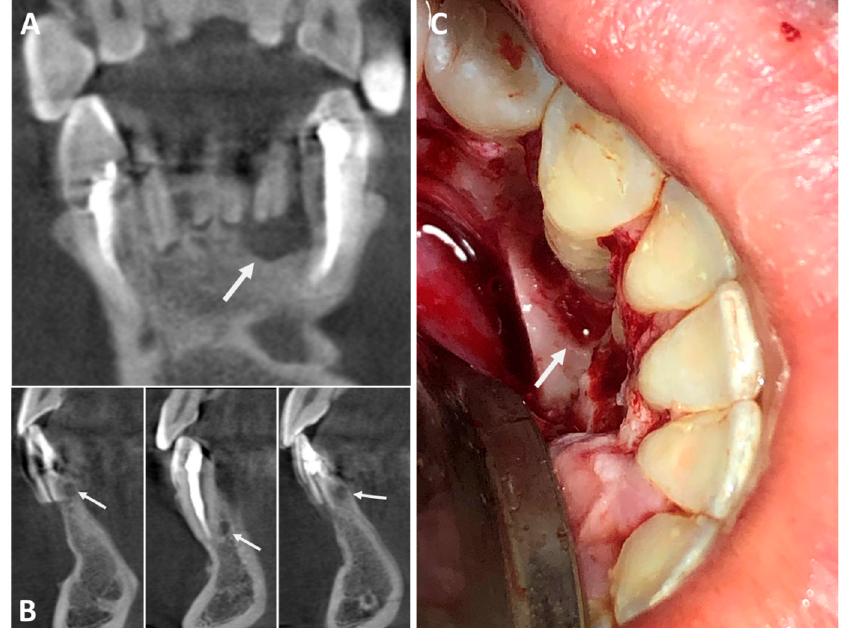
Figure 4. ( A )—Representative coronal cut and ( B )—sagittal cuts of the CT scan 8 months after the first surgery, revealing recurrent lesions in the apical region, lingually. ( C )—Trans-operative image of the second surgical approach, aiming the removal of the recurrent lesion in the lingual portion of the cortex. The arrows point to the recurrent lesions.